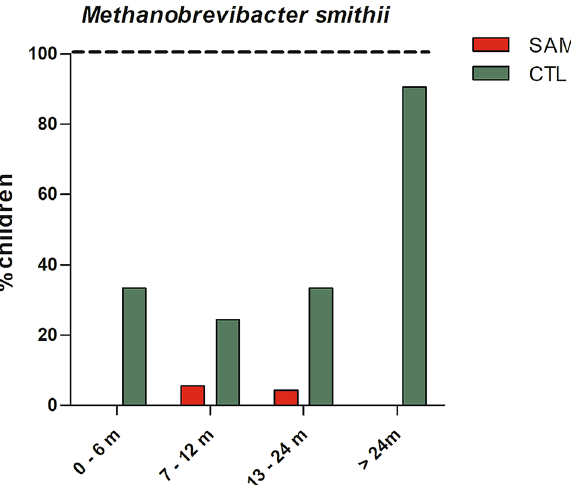
Figure 3. Age group detection of Methanobrevibacter smithii in malnourished and healthy children. Proportion of positive children is shown in each age range, green bar represents healthy control and red bar malnourished